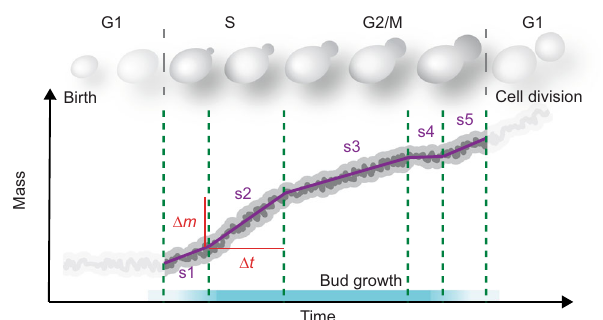
Fig. 5. Model of a single yeast cell increasing mass throughout the S/G2/ M phase in linear segments of constant growth rates. The schematic of the budding yeast cell cycle above the plot ranges from the birth (G1 phase) to the budding phase (S/G2/M), the cell division, and the forthcoming G1 phase. During the S/G2/M phase, single S. cerevisiae cells increase mass Δ m in linear segments (purple lines), each lasting for a certain time Δ t . Each linear segment (here s1 – s5) shows a different growth rate ( GR); GR = Δ m / Δ t (Fig. 4) and lasts over a different time period Δ t . At the resolution of our mass measurements, we observe single yeast cells to progress through the S/G2/M phase (cyan bar at bottom) on average in fi ve linear growth